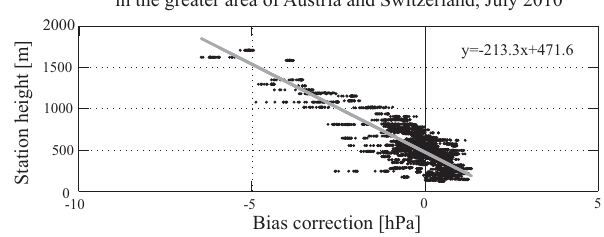
Fig. 4. Bias correction (black dots) for 2 as a function of the sta- tion height, evaluated for stations in the greater area of Austria and Switzerland in July 2010. The regression line (gray line) shows that the higher the stations, the more negative the bias corrections are. The absolute height limit of the station selection algorithm (opera- tionally 1500m) was raised to 1800m for this case